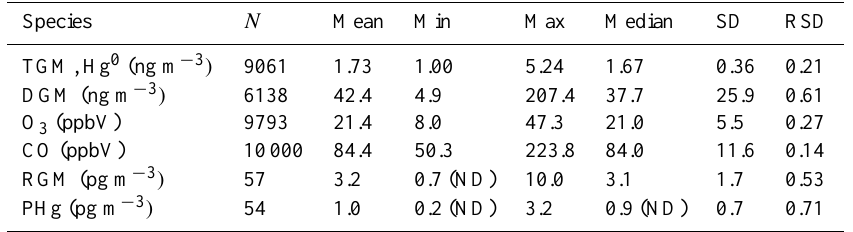
Table 2. Summary of the measurements after screening the raw data from local combustion.